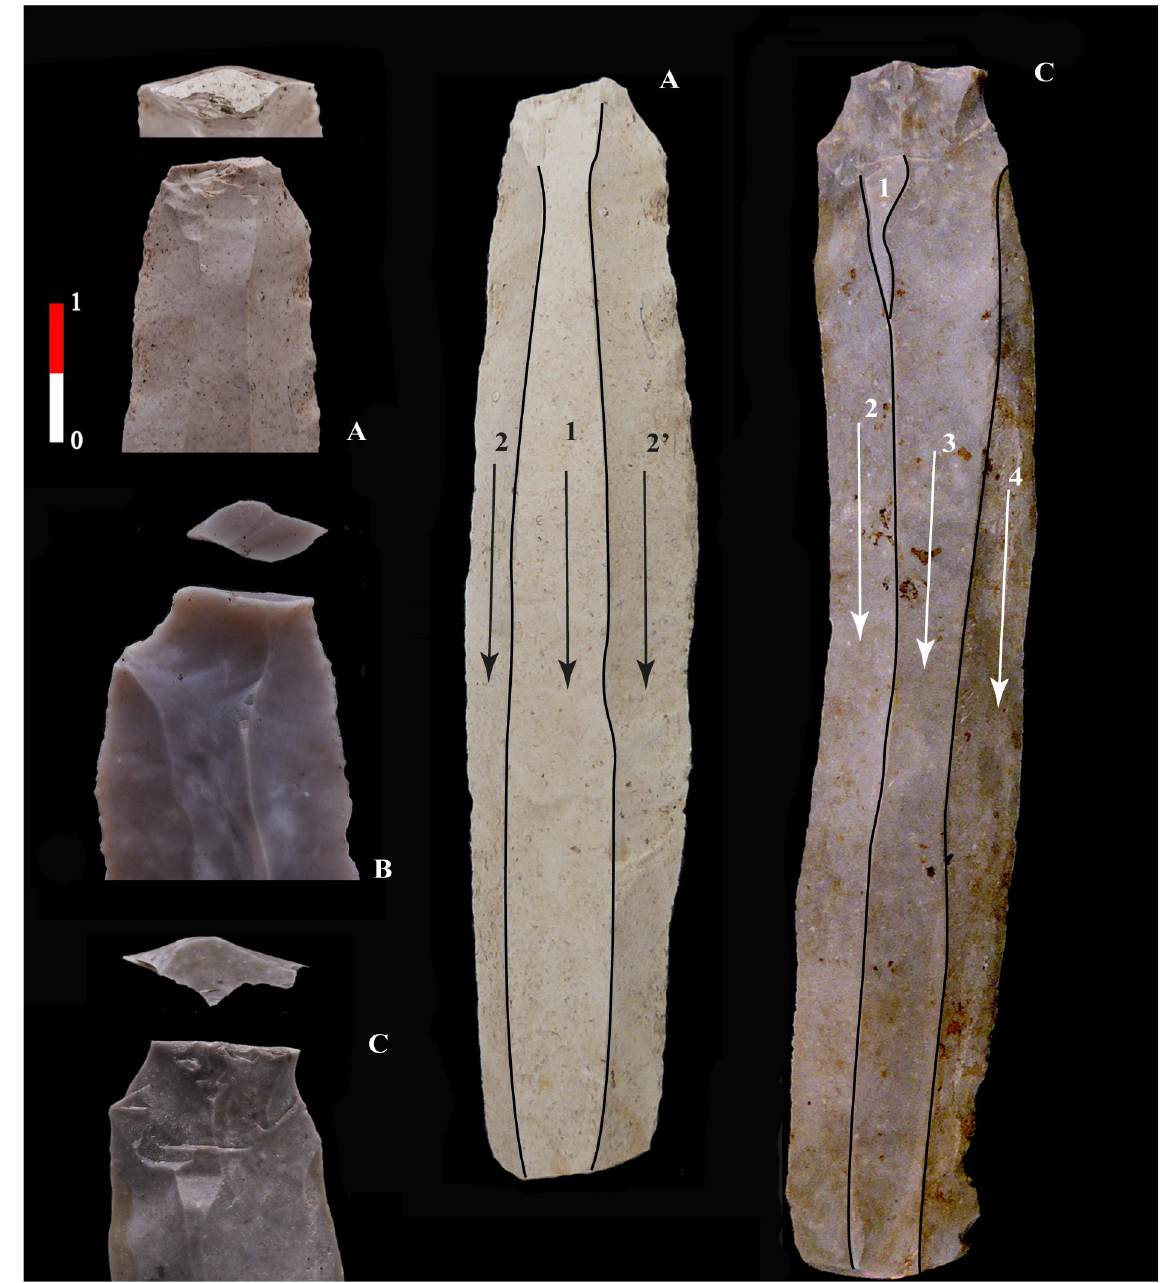
Fig 2. Example of diagnostic blades for indirect percussion. Three examples of blades characteristic of punch technique: A, a regular blade from Bucy-le-Long "la Fosse Tounise" (with a partially prepared overhang and a 90˚ platform angle ((BLF, 44–1280, Soissons, France); B, a blade from Bucy-le-Long "la He´ronni è re" with a flat butt, a half-circle behind the platform and a rough overhang (BLH, 124–2727, Soissons, France); C, typical Early Neolithic blade from Hesbaye. The butts of the blade is plain and flat, with residues of the overhang (ACM, 150–8497, Aubechies,